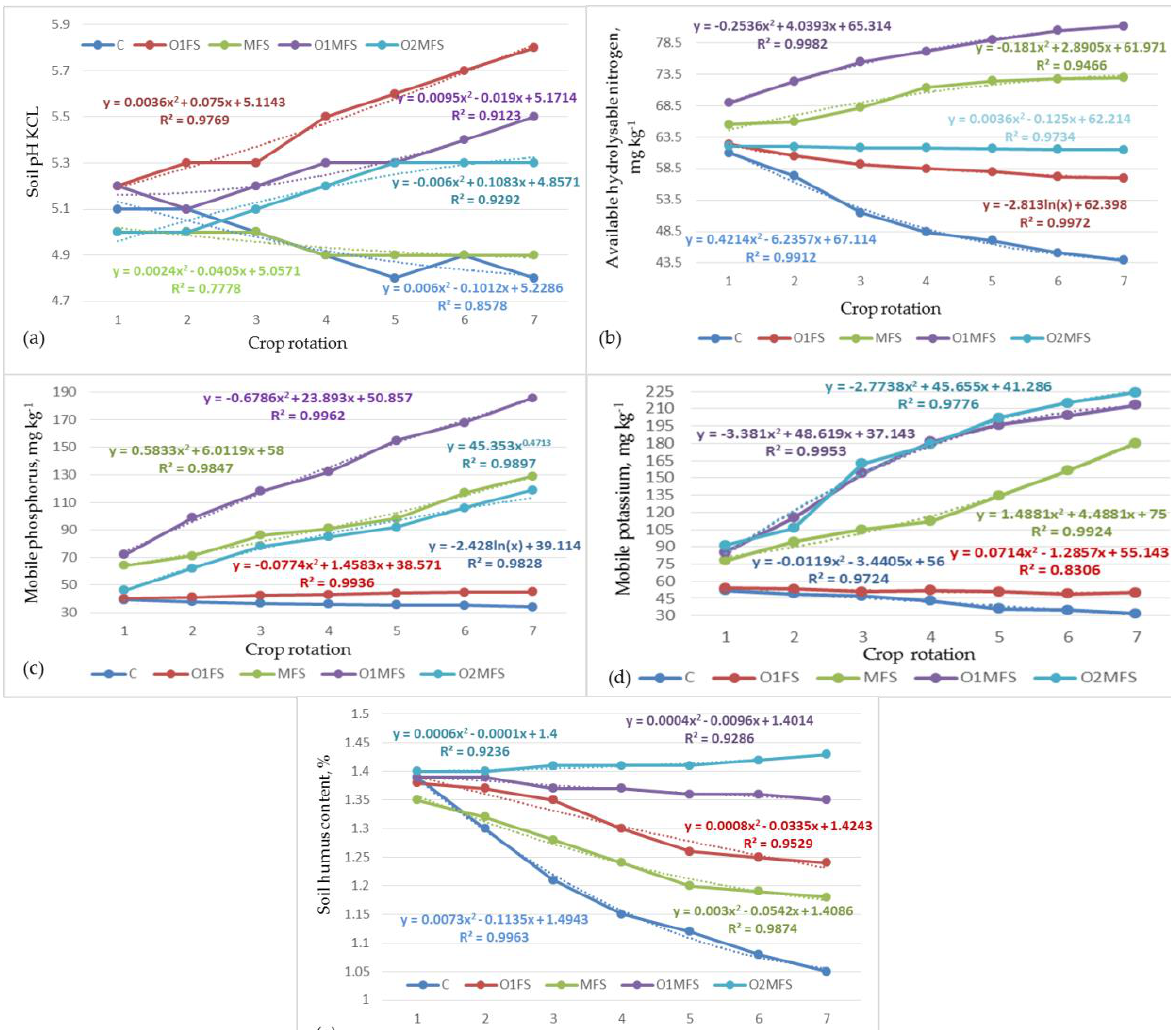
Figure 3. Changes in soil physical, chemical, and agrochemical properties depending on fertilization system and number of crop rotations. Average data at the end of crop rotation cycle: ( a )-pH KCl; ( b )-available hydrolysable nitrogen; ( c )-mobile phosphorus; ( d )-mobile potassium; ( e )-humus content. Experiment variants: without fertilizer (C); organic fertilization system, manure (O1FS); mineral fertilization system, NPK (MFS); organic-mineral fertilization system, manure + NPK (O1MFS); and organic-mineral fertilization system, siderate + NPK (О2MFS).